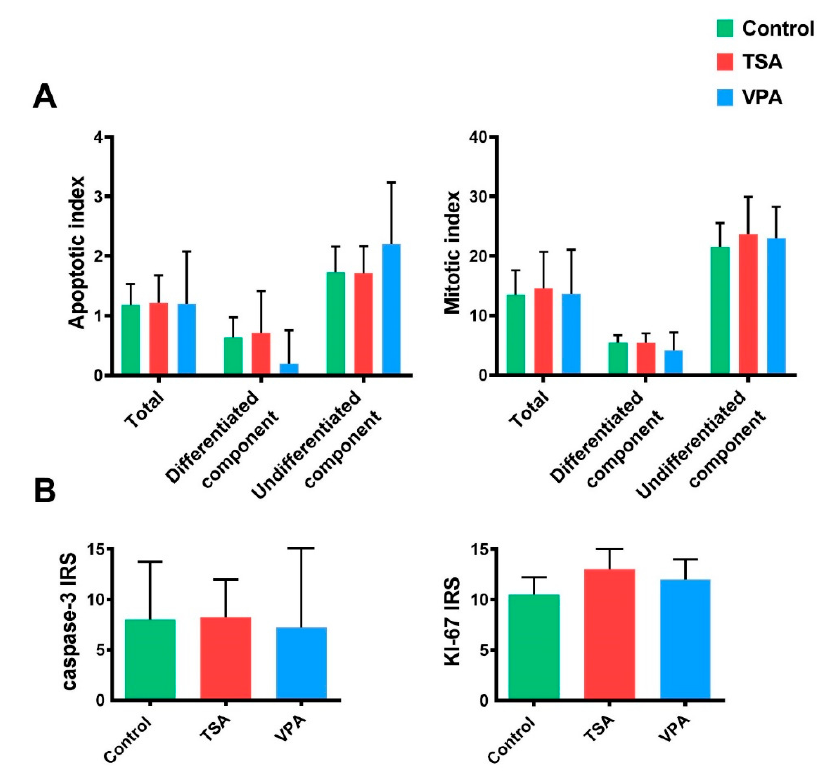
Figure 6. Analysis of apoptosis and proliferation. ( A ) Apoptotic and mitotic indices have been measured in in vitro-cultured teratoma HE slides as total number of apoptotic or mitotic cells in differentiated and undifferentiated teratoma tissue. Values represented are means with 95% CI. ( B ) IHC analysis of apoptosis and proliferation in in vitro-treated teratoma. Proliferation has been analyzed based on Ki-67 protein expression, while apoptosis by caspase-3 expression. Values represented are means with 95% CI.